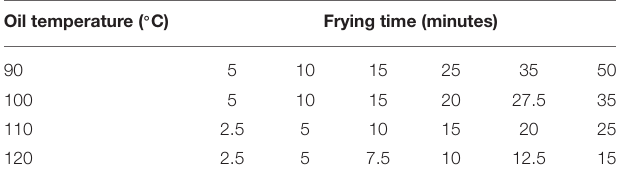
TABLE 2 | Settings used for vacuum frying mango